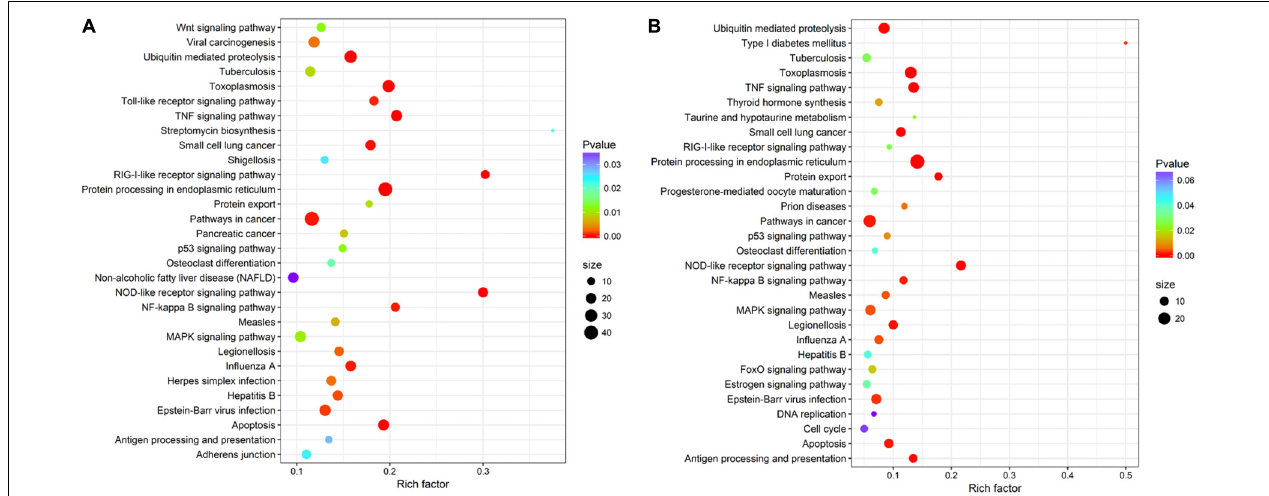
FIGURE 6 | Top 30 pathways enrichment statistics between control and heat stress temperature. (A) Pathway enrichment in the RL. (B) Pathway enrichment in the YL.